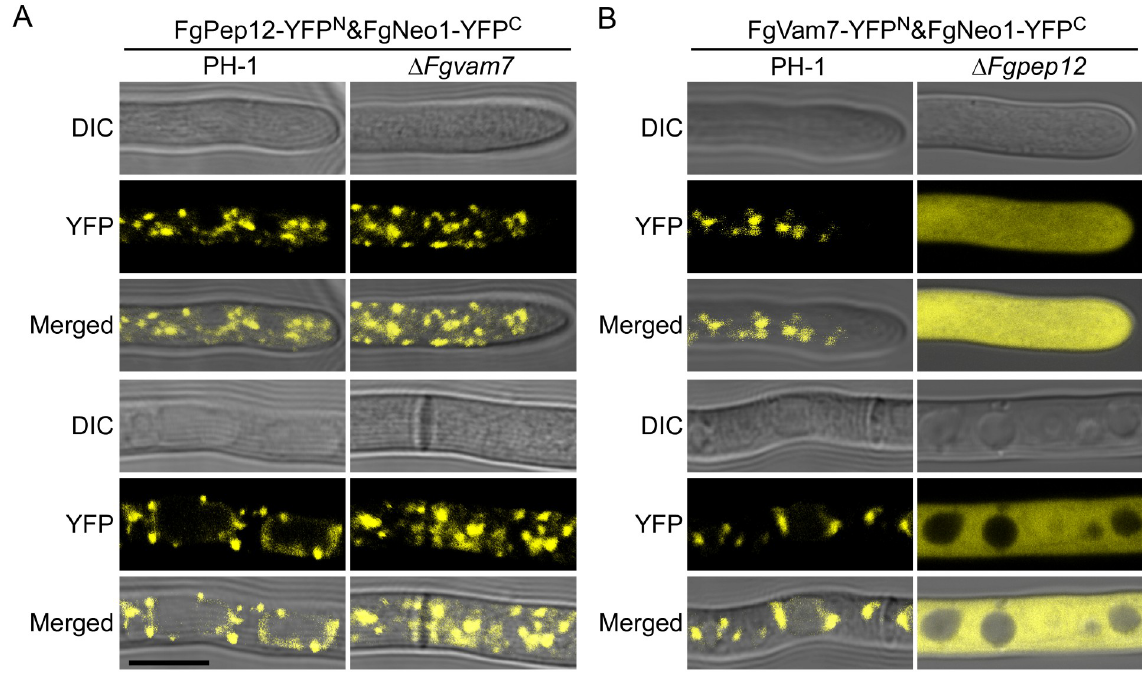
Fig 11. Deletion of FgPep12 affects the localization pattern of FgVam7&FgNeo1. (A) Hyphae of transformants expressing FgPep12-YFP N &FgNeo1-YFP C in the wild type PH-1 and Δ Fgvam7 were examined by DIC or fluorescence microscope. (B) Hyphae of transformants expressing FgVam7-YFP N &FgNeo1-YFP C in PH-1 and Δ Fgpep12 were examined by DIC or fluorescence microscope. Bar = 10 μ m.